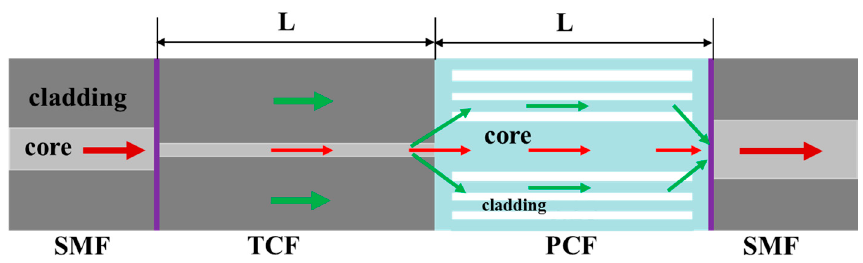
Figure 1. Schematic diagram of the MZI based on TCF-PCF structure.